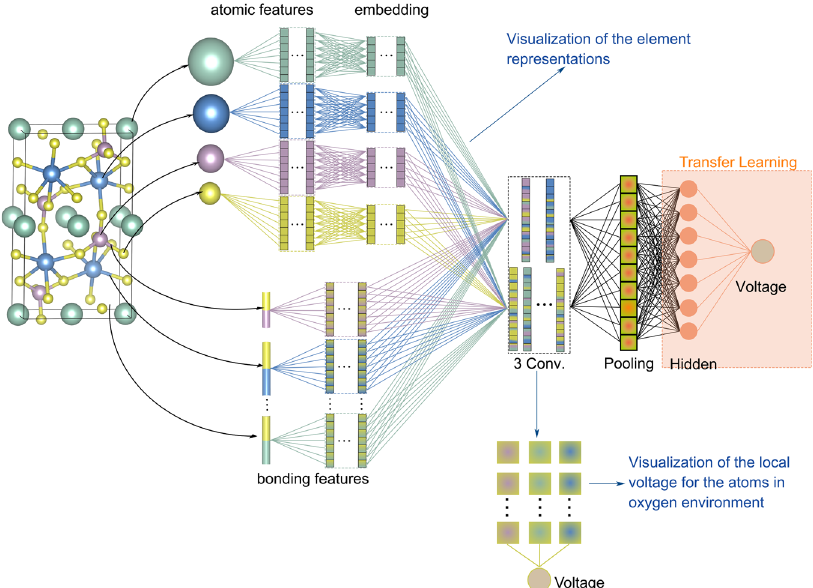
Fig. 1 Illustration of the interpretable crystal graph convolutional neural network. A crystal is converted and characterized by atomic and bonding vectors. The elemental and local environment representations for visualization of the model are constructed from the embedding and the convolutional layers, respectively. The weights in the hidden layer and output layer are trained during transfer